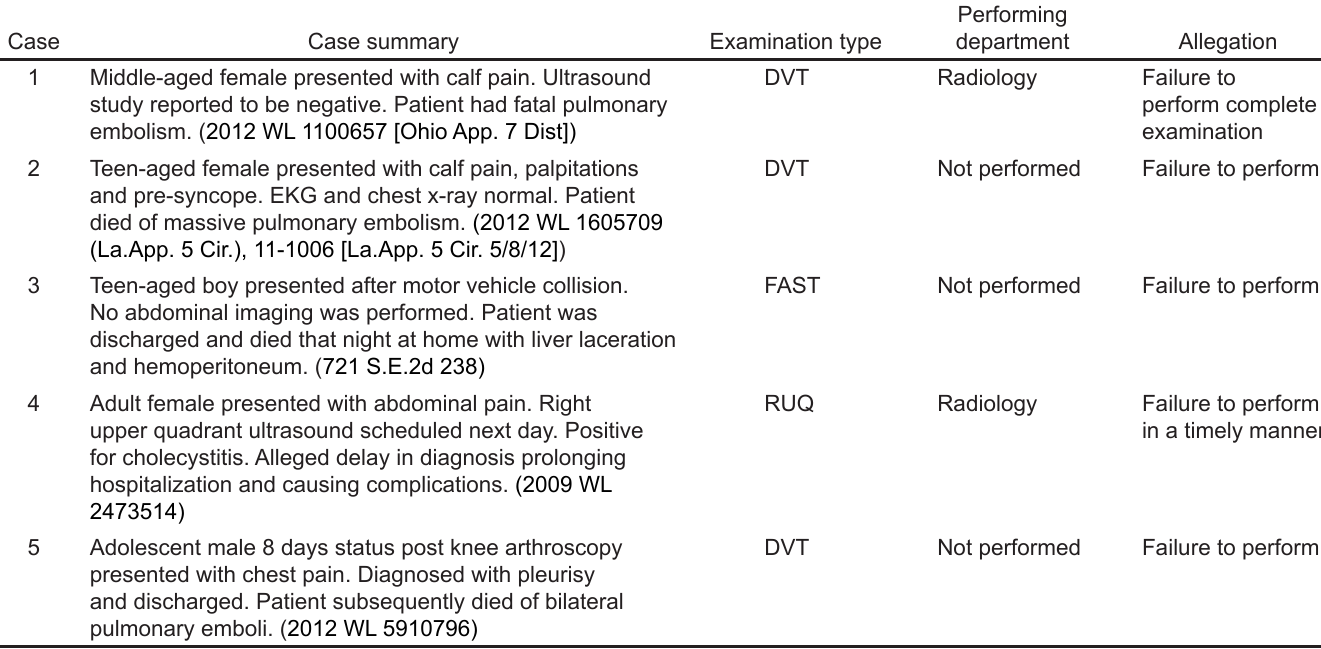
Table. Summary of cases involving emergency physicians and point-of-care ultrasound.